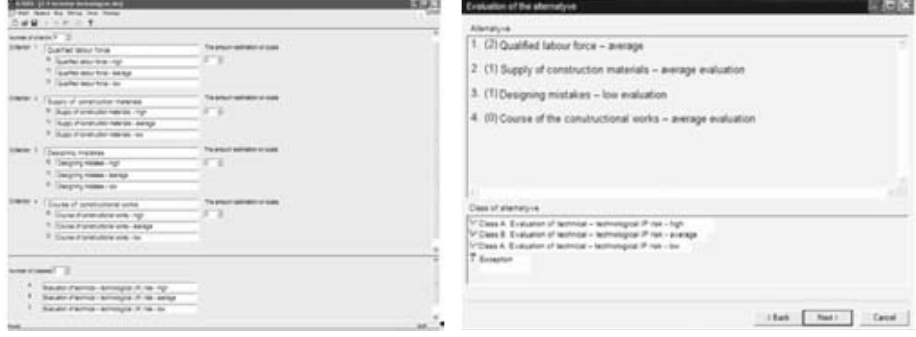
Fig. 5. Evaluation of the alternative Fig. 4. Data input into the program